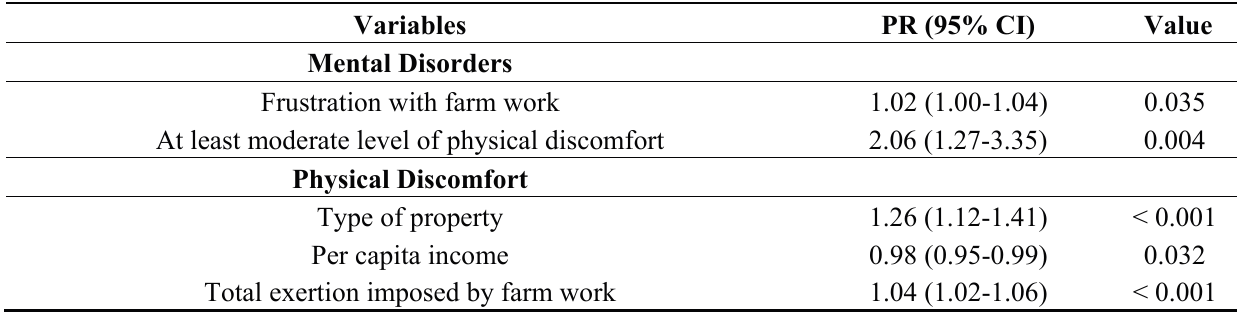
Table 2. Poisson regression analysis to assess factors associated with mental disorders and physical discomfort among female farm workers from the interior of the state of Rio Grande do Sul,